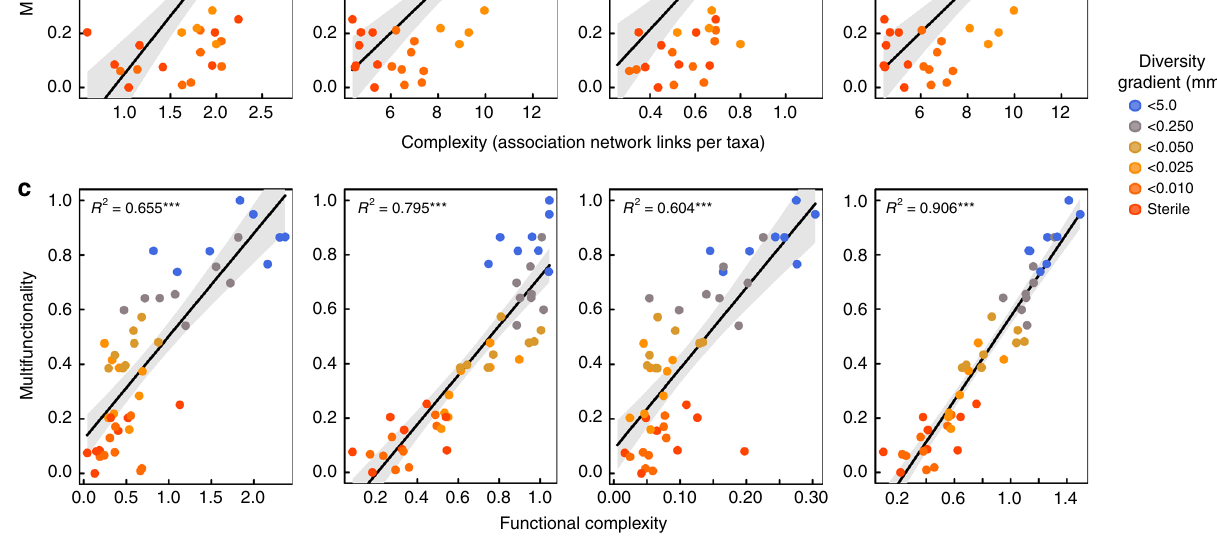
functions in support of the diversity – multifunctionality hypoth- esis previously observed along plant diversity gradients 24,25 .